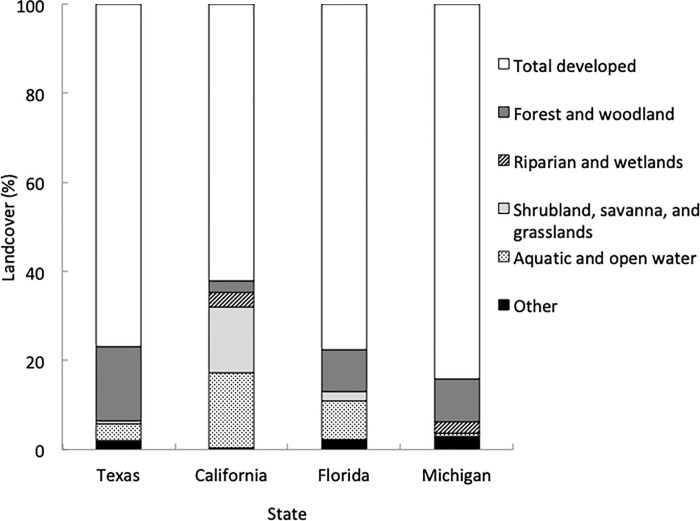
Land cover composition.Overall land cover composition (expressed as percentages) of the environment surrounding honey bee colonies used in each state, using a four-km foraging radius around each colony site. The “other” type of land cover represents cultivated croplands, recently disturbed or modified, pastures or hay, sparse and barren systems, and introduced and semi-natural vegetation.